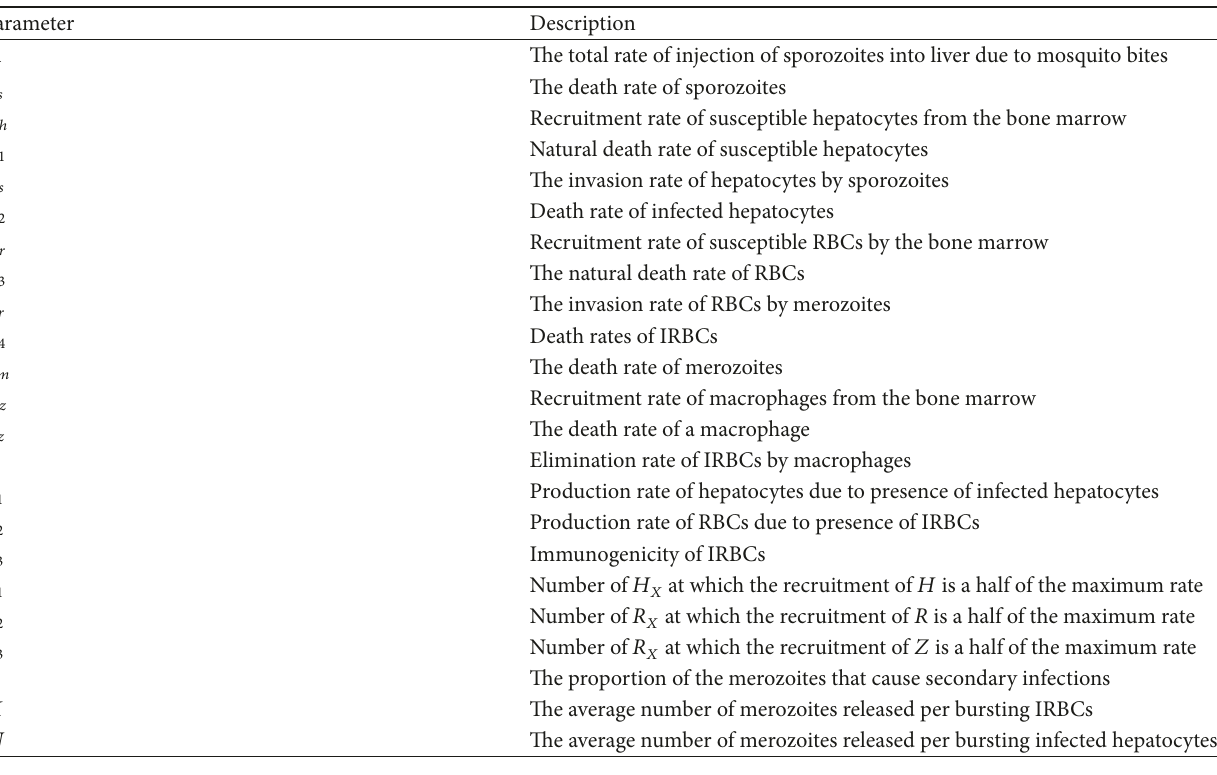
Table 2: Symbols and description of parameters used in the